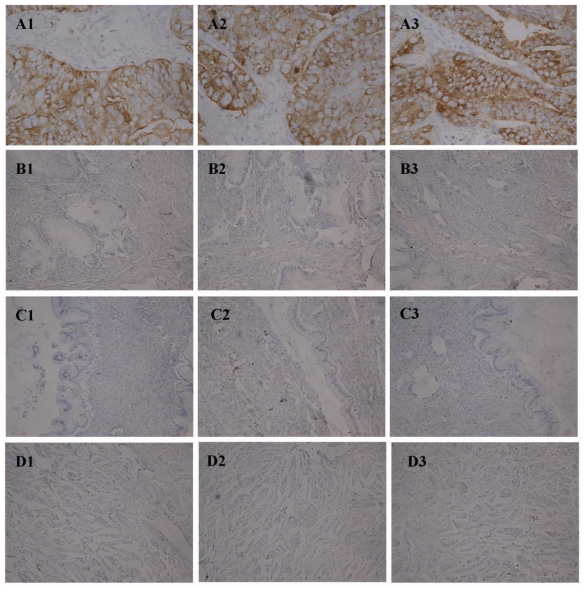
Immunohistochemical staining in ovarian malignant tumor (A1–A3), borderline tumor (B1–B3), benign tumor (C1–C3) and normal ovarian tissue (D1–D3). Integrin αv (A1, B1, C1, D1); β3 (A2, B2, C2, D2) and Lewis y (A3, B3, C3, D3). (Original magnification ×200).